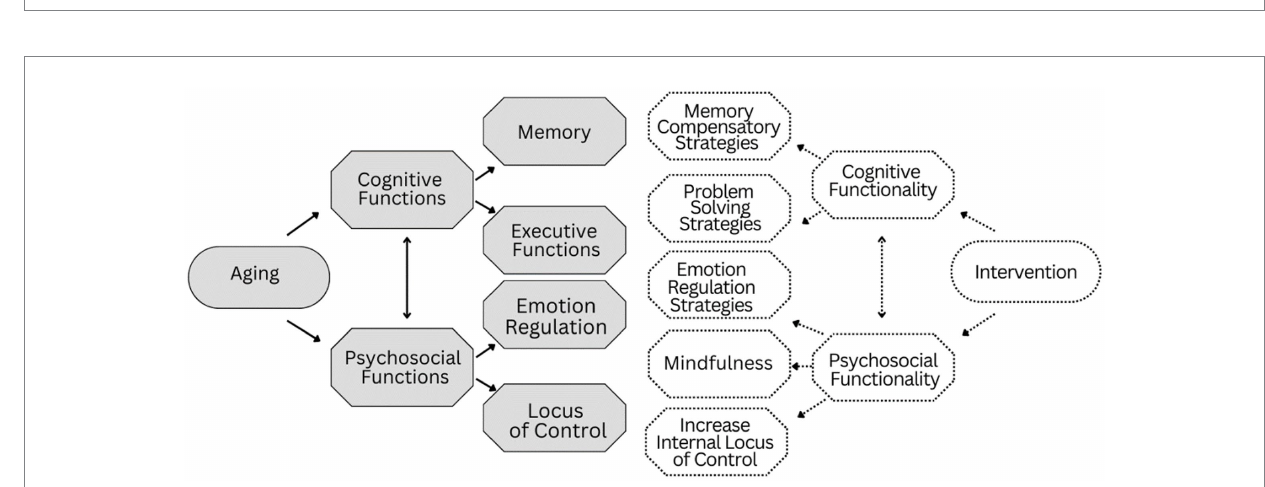
FIGURE 2 Conceptual framework of the intervention